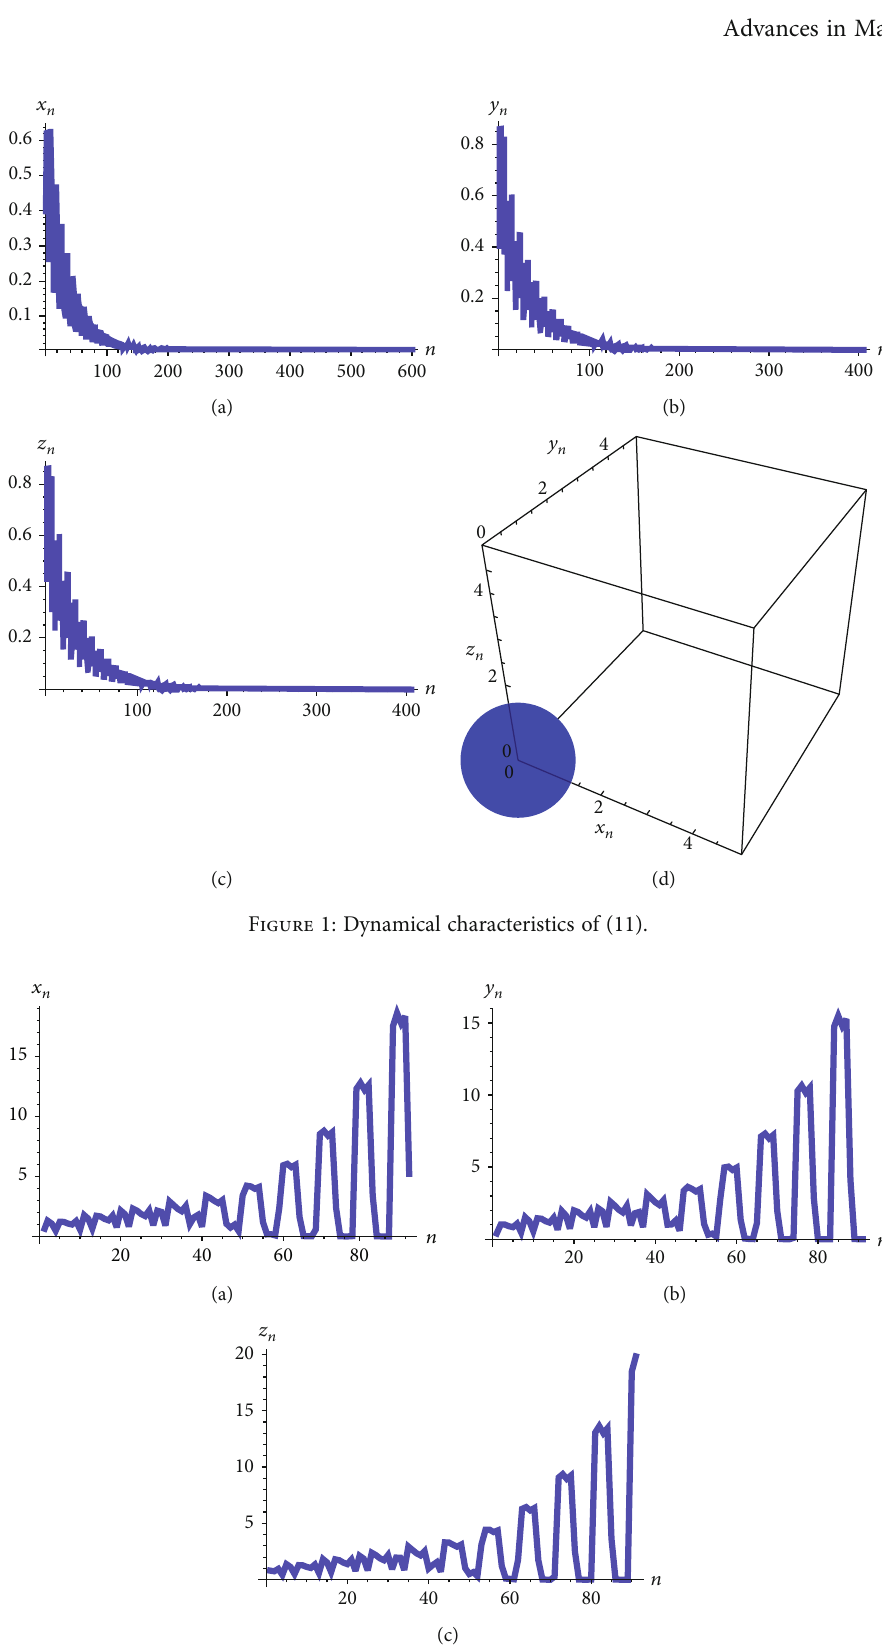
Figure 2: Dynamical characteristics of (11).